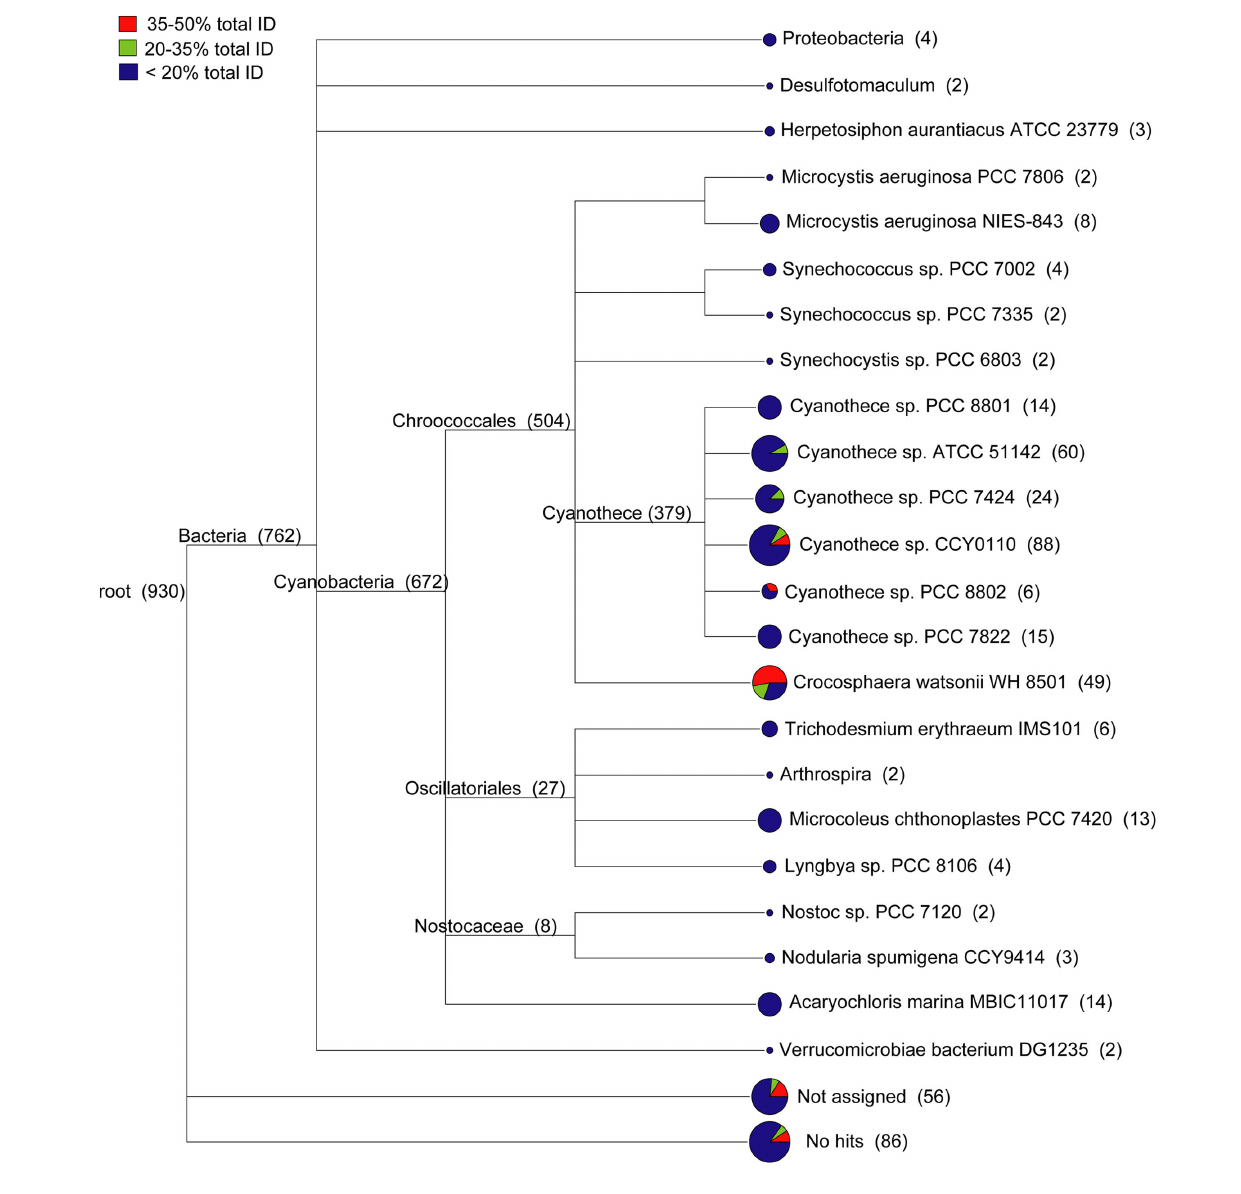
The number of sequences in each bin were as follows: 751 in the < 20% bin; 75 in the 20–35% bin; and 104 in the 35–50% bin. Pie charts show the relative contributions of the three bins to each